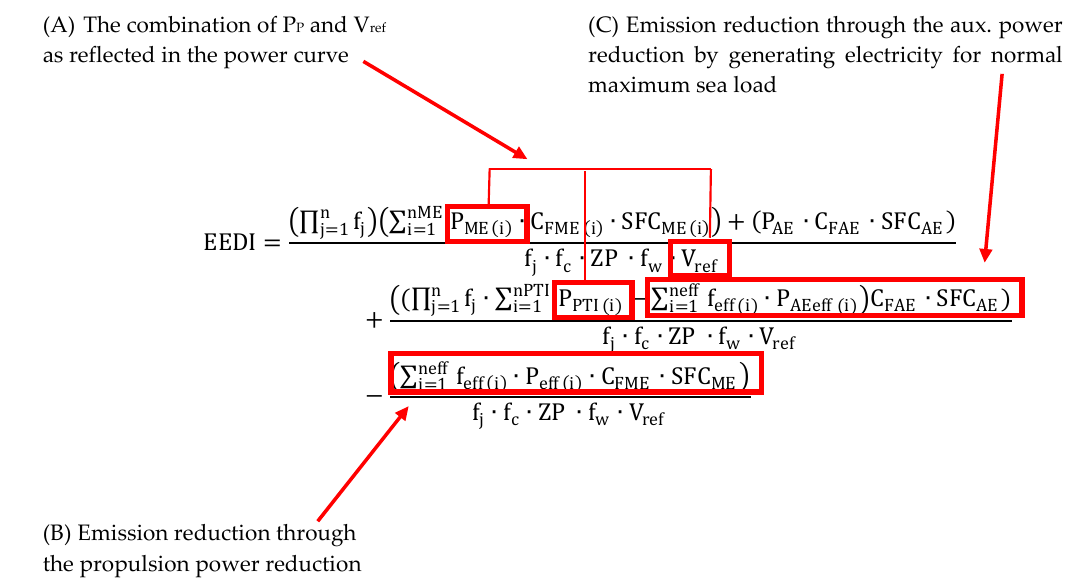
Figure 1. The Energy Efficiency Design Index (EEDI) formula with indicated elements that may affect the emission reduction by the use of ALS.